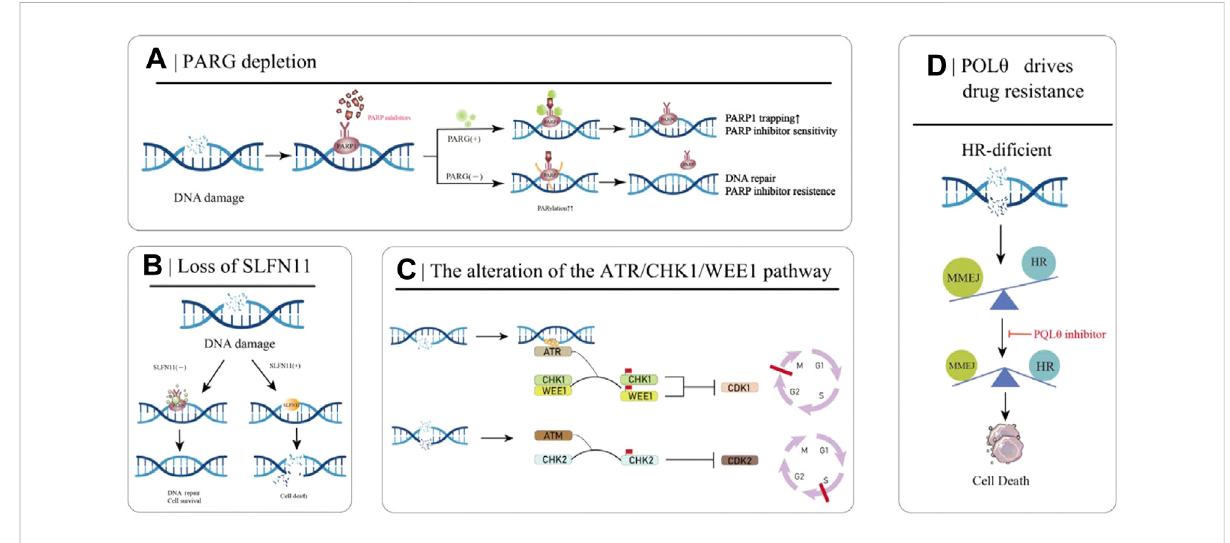
FIGURE 3 Partial mechanisms of PARP inhibitor resistance in cancer. (A) PARG deletion leads to PARPI resistance. (B) Loss of SLFN11 enhances DSB repair capacity, ultimately leading to PARPi resistance. (C) The ATR/CHK/WEE1 signaling pathway arrests the cell cycle to reduce replication stress and promoteDSBrepair. (D) HR-de fi cientcellsrelyonMMEJforDSBrepair,whichismediatedbyPOL θ .InhibitionofPOL θ inHR-de fi cientcellsresultsin cell